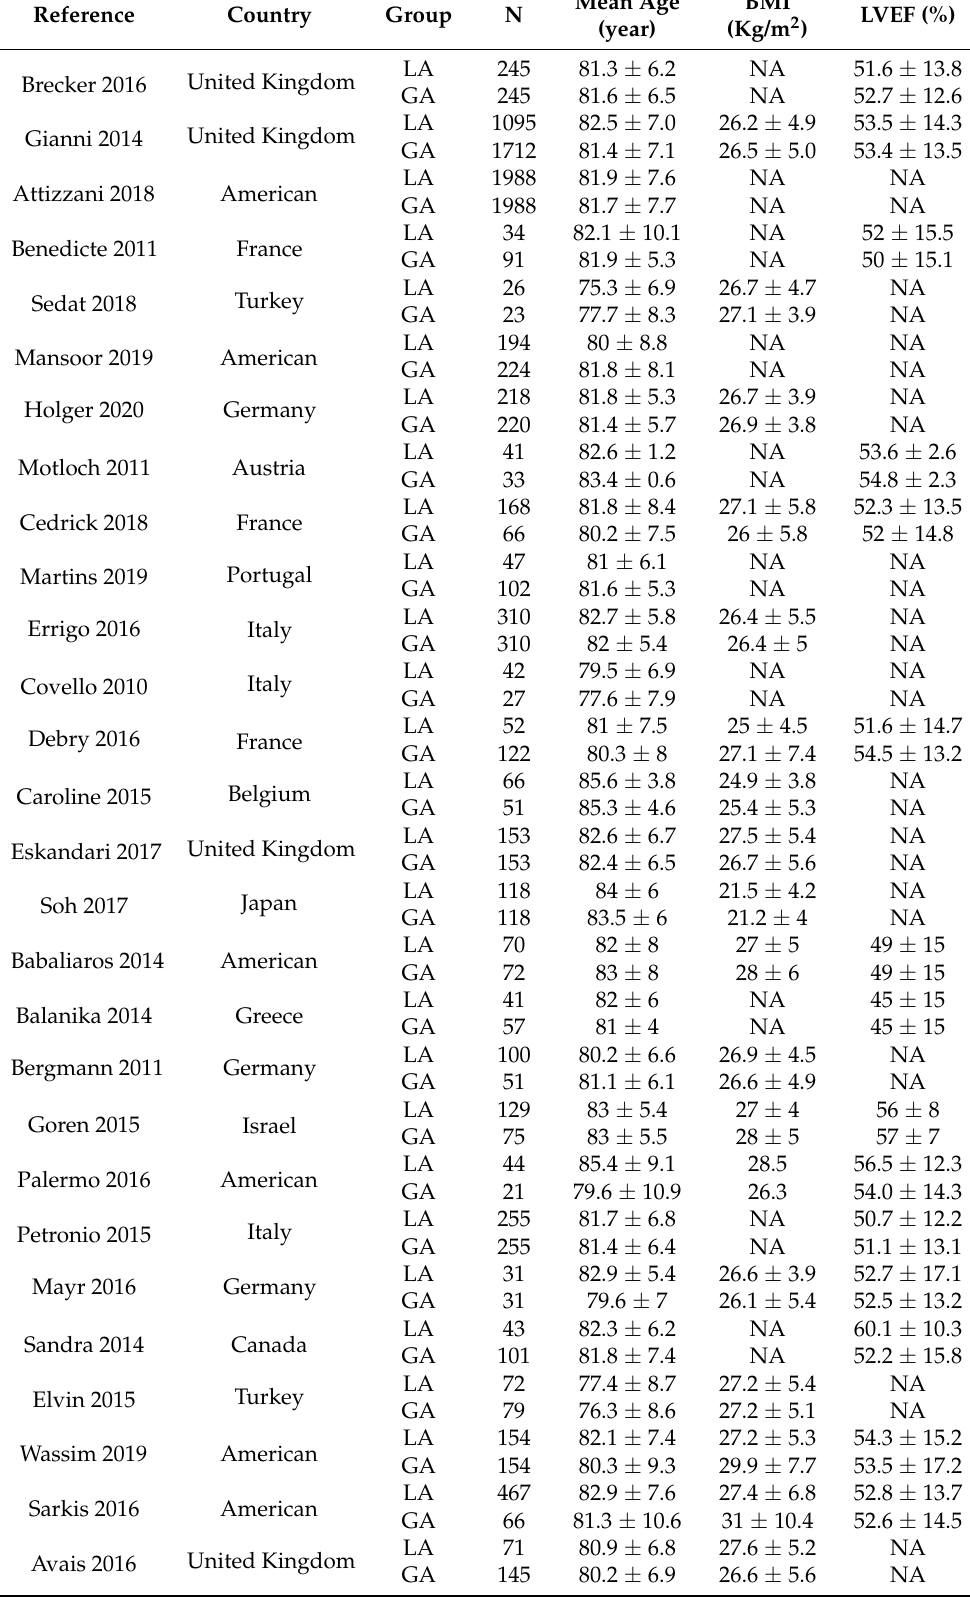
Table 1. Baseline characteristics of included studies for